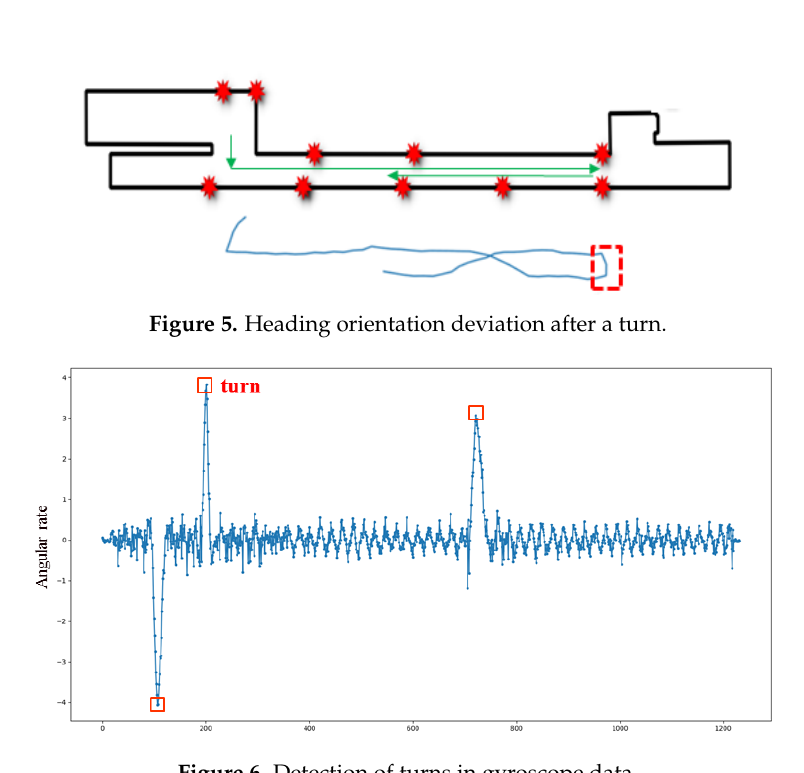
Figure 6. Detection of turns in gyroscope